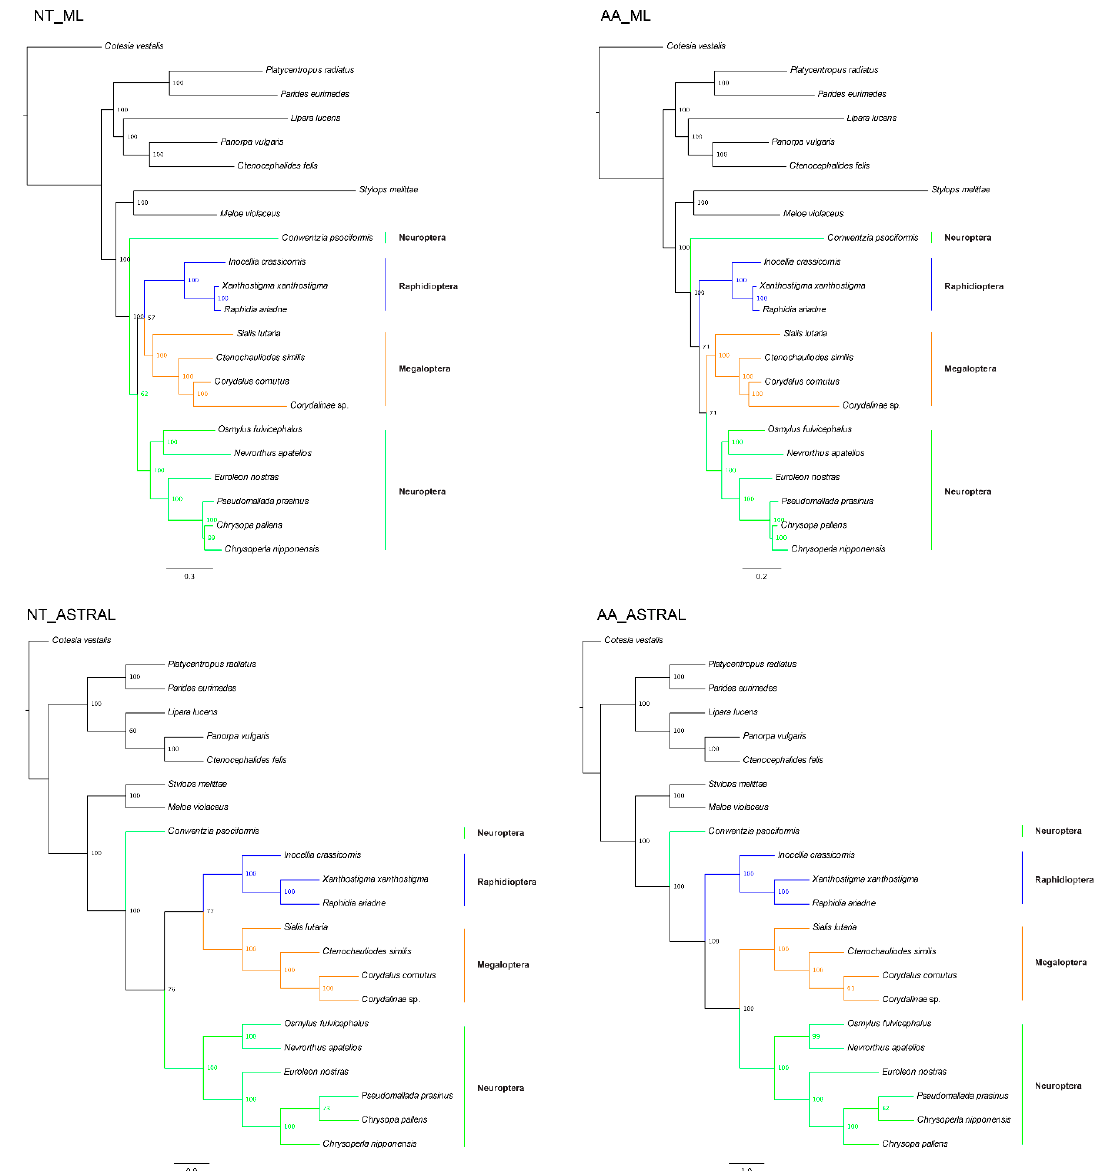
Figure 2. Phylogenetic reconstructions of Neuropterida using different dataset and different methods under the site-homogeneous model. The numbers on the right of each node are the bootstrap support values. Branch color represents the different order of Neuropterida (Blue for Raphidioptera, orange for Megaloptera, and green for Neuroptera). NT: Nucleotide. AA: Amino acid. ML: The concatenated tree from maximum likelihood. ASTRAL: The coalescent tree from ASTRAL.